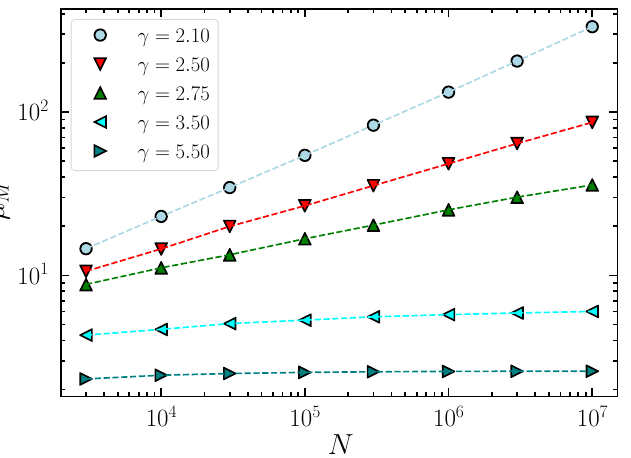
Figure 1. µ M for uncorrelated networks. Scaling of the LEV of the NB matrix, µ M , as a function of network size N in power law UCM networks with different degree exponent γ . Dashed lines correspond to the theoretical prediction Eq. (8). Simulations results correspond to the average over 25 different network realizations. Error bars are smaller than symbols size.